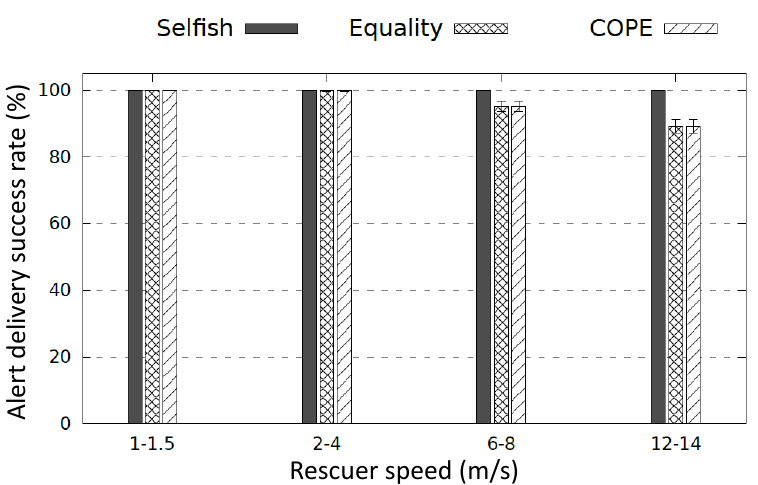
Figure 11. Alert delivery success rate where all nodes are alive.